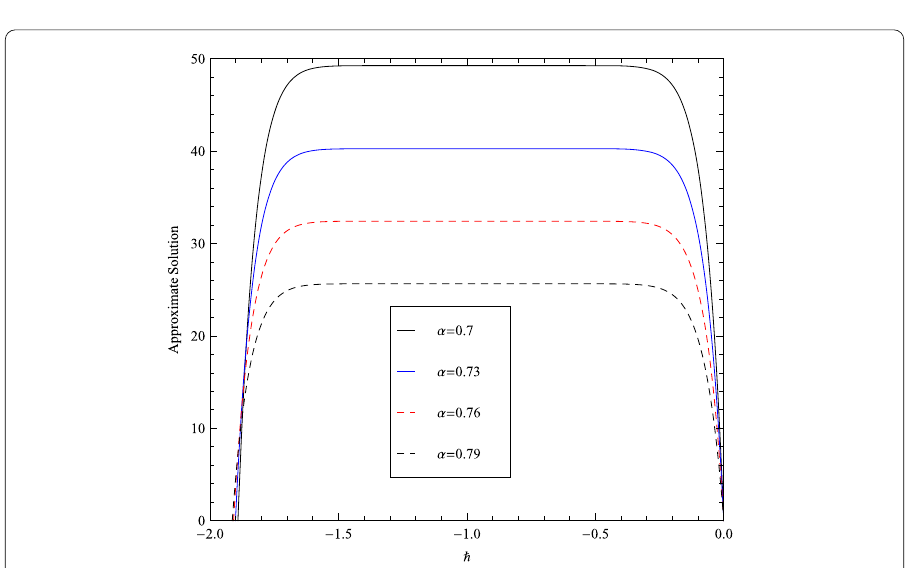
Figure 4 Plot of (cid:2) curve for different values of λ at x = 0.5 and t =